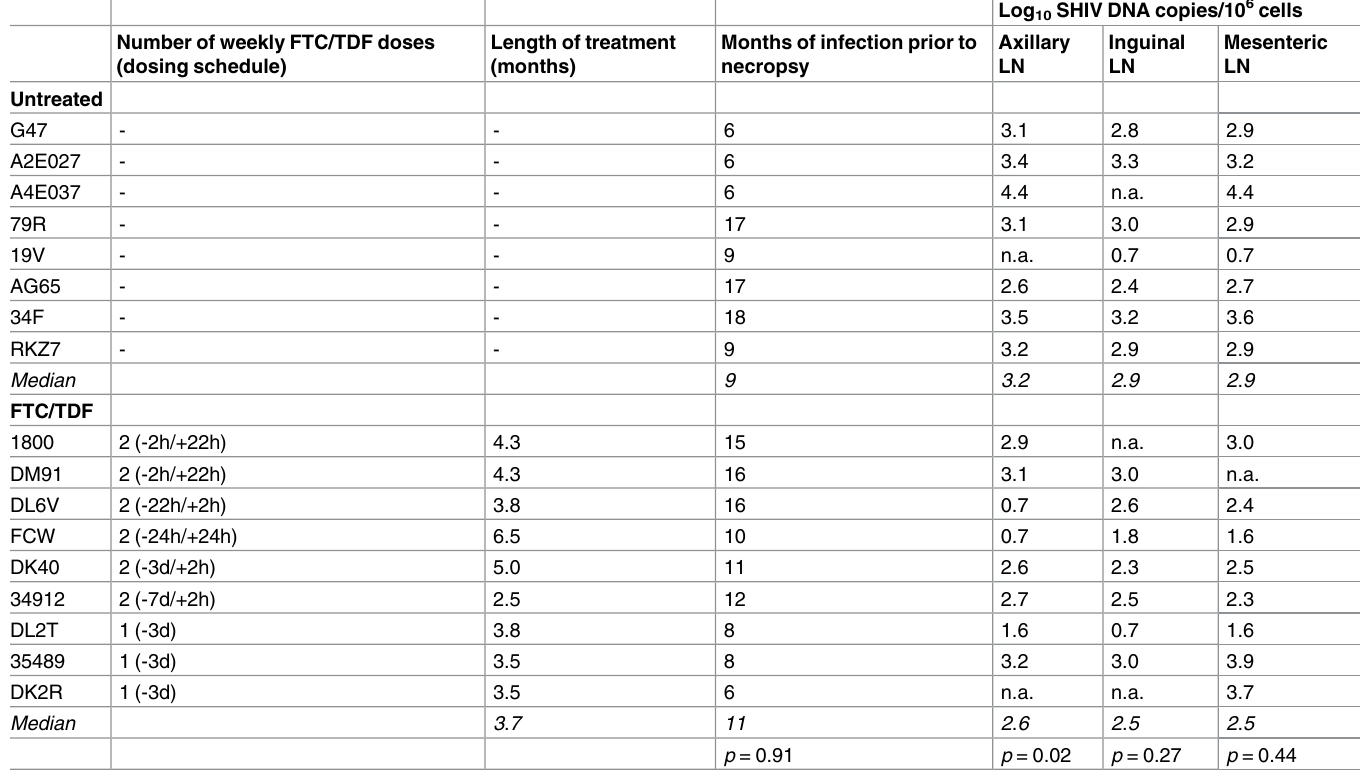
Table 3. SHIV 162P3 DNA levels in lymphoid tissues from PrEP breakthrough and placebo